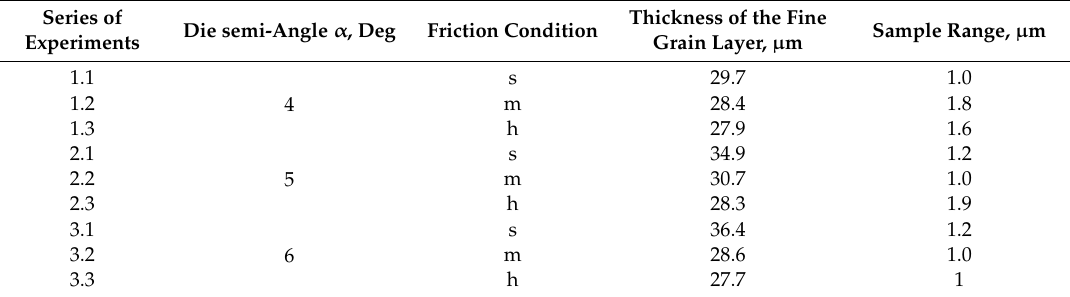
Figure 10. Effect of the die semi-angle on the thickness of the fine grain layer at different friction conditions.